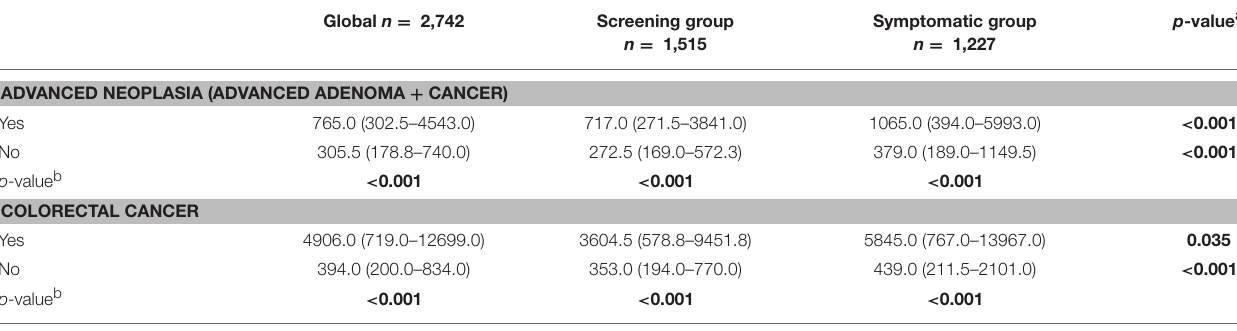
TABLE 3 | Hemoglobin FIT values according to advanced neoplasia and colorectal cancer alone.